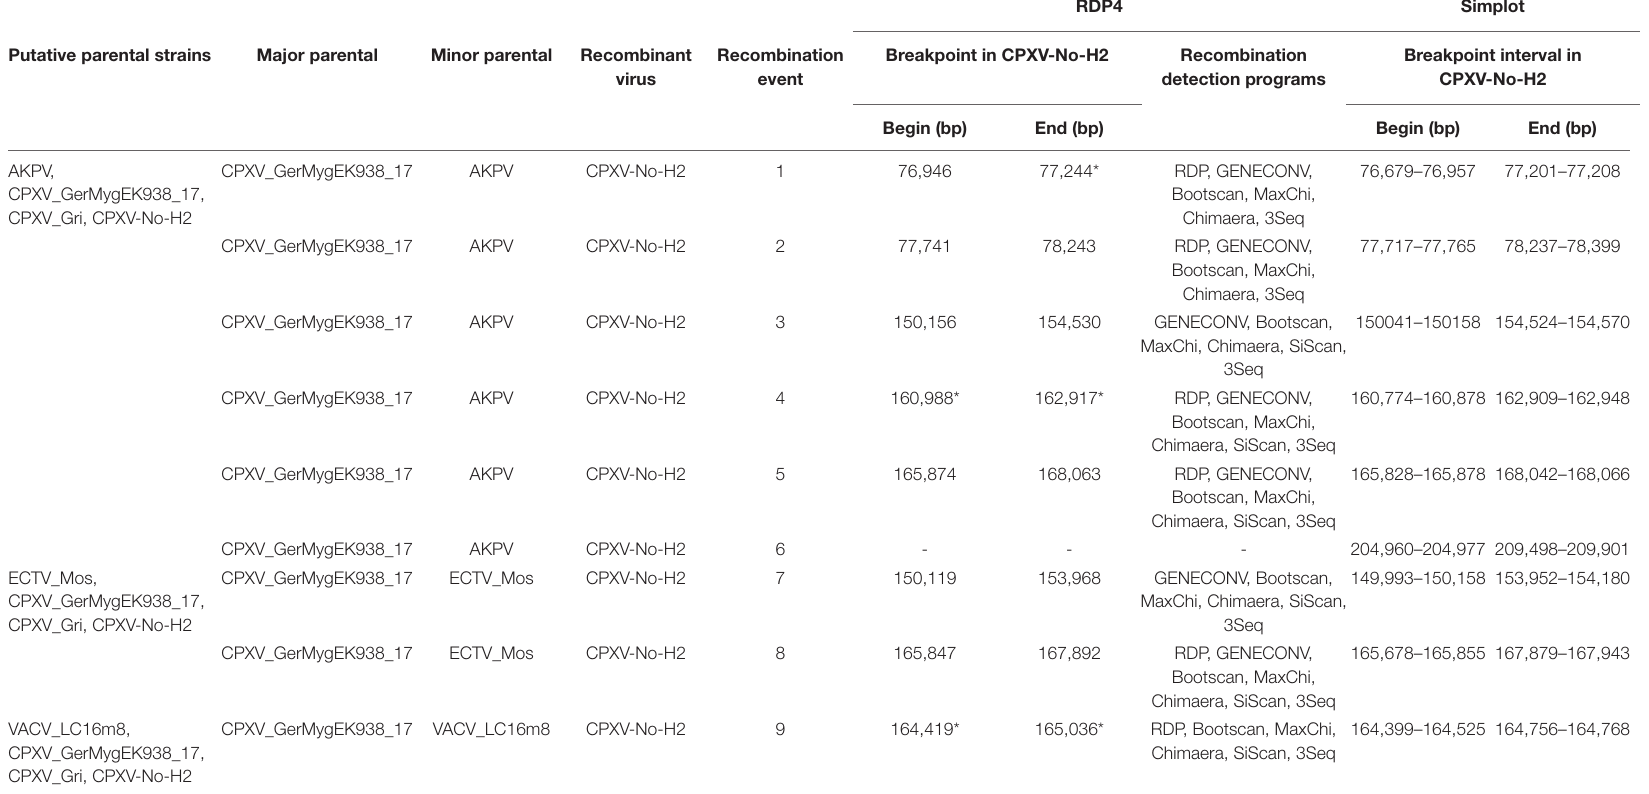
The breakpoint that was undetermined is marked with an asterisk. AKPV, Alaskapox virus; CPXV, Cowpox virus; ECTV, Ectromelia virus; VACV, Vaccinia virus.